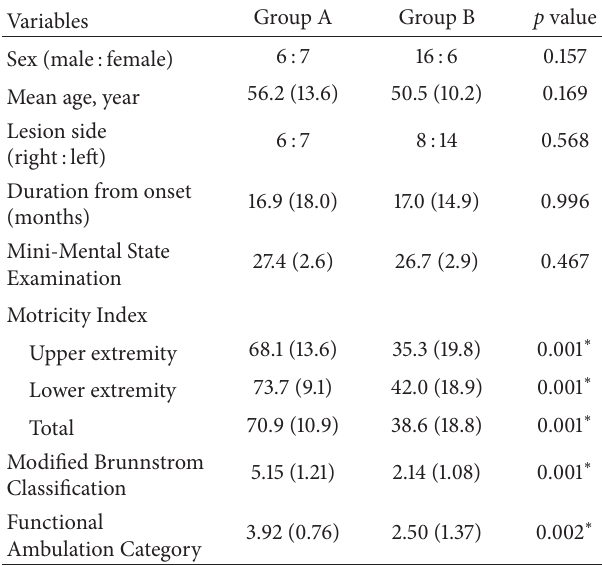
Table 1: Demographic and clinical data according to diffusion tensor imaging findings of the corticospinal tract for